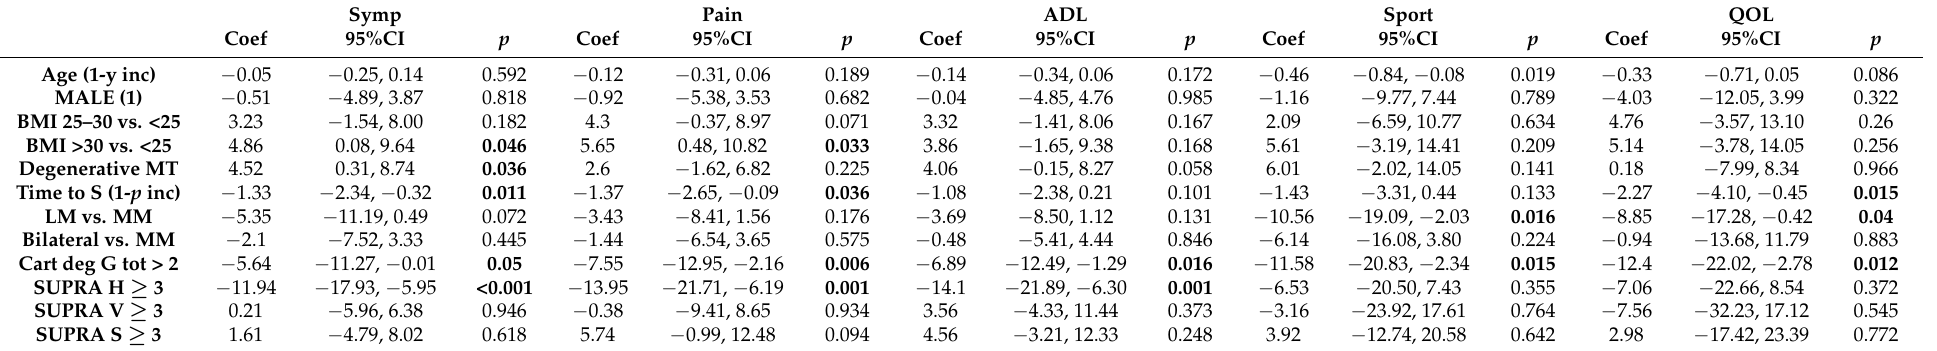
Table 5. Multivariable regression models